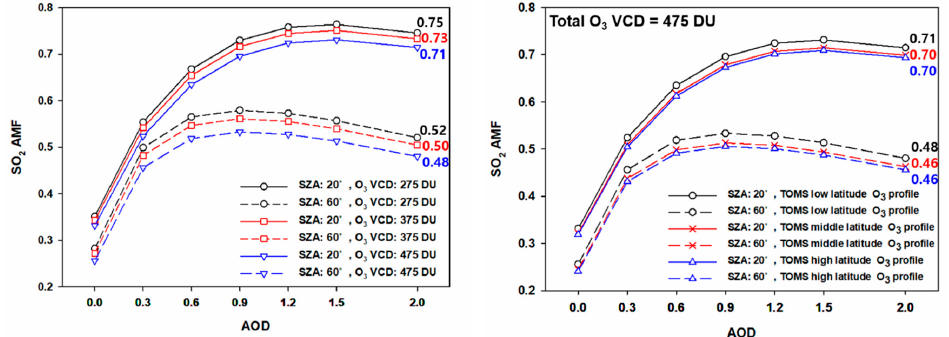
and ( b ) O 3 profiles at low and high SZA (VZA = 40°; RAA = 45°; surface reflectance = 0.05; wavelength = 318 nm; APH = 0